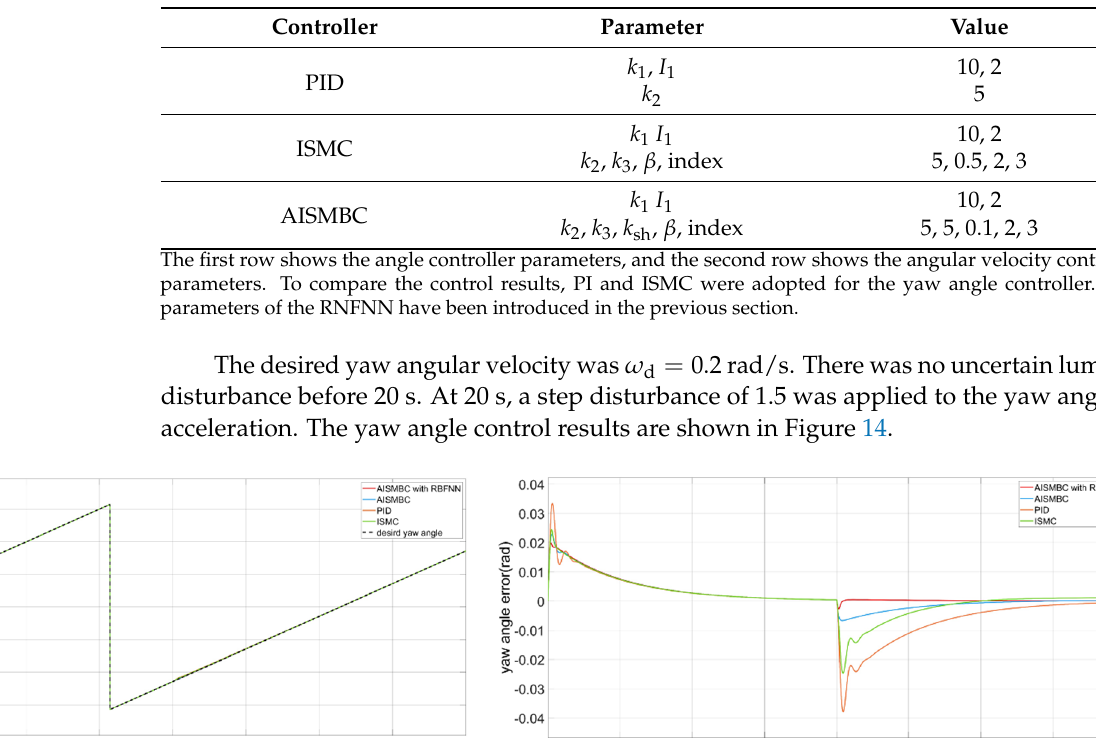
Table 3. Parameters of the yaw angle controllers.